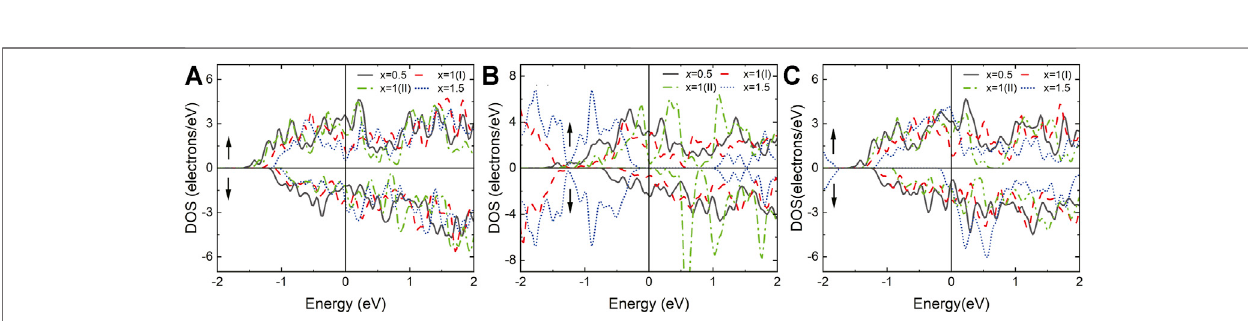
Frontiers in Chemistry |